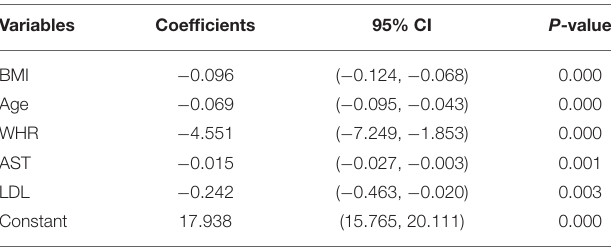
TABLE 4 | The regression coefficient and 95% CI of the equation.